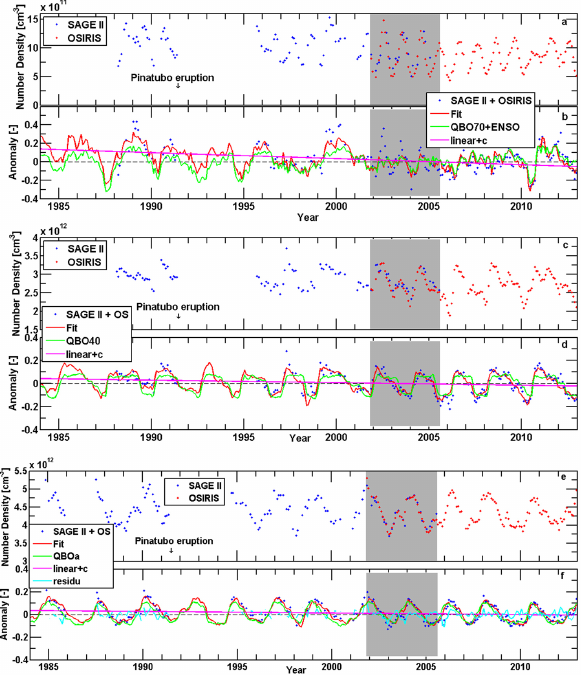
Fig. 5. This figure consists of three two-panel plots. The upper panel in each shows the ozone number density time series from SAGE II and OSIRIS (“OS”) separately. The overlap period is shaded grey. Note that these are the original data (no inter-instrument bias re- moved). The lower panel in each plot is the merged ozone anomaly time series (blue dots). The red line represents the fit provided by the regression model to this time series. The green line shows the ozone response of the dominant predictor (predictors) which cor- relates (correlate) with the dependent variable to >0.5. The three altitudes shown from top to bottom are 18.5, 21.5, and 24.5km. The ozone data have been filtered at the start of the SAGE II record as described in Sect. 2.1.1, most extensively at 22.5km and below, because of the residual aerosol layer from El Chichón (peak altitude of 19.5km in 1985), which erupted in April 1982, and then Nevado del Ruiz, which erupted on 13 November 1985 (Yue et al., 1991) and whose peak altitude was 22.5km in early 1987. The eruption of Mt. Pinatubo, which occurred in June 1991, is marked in the upper